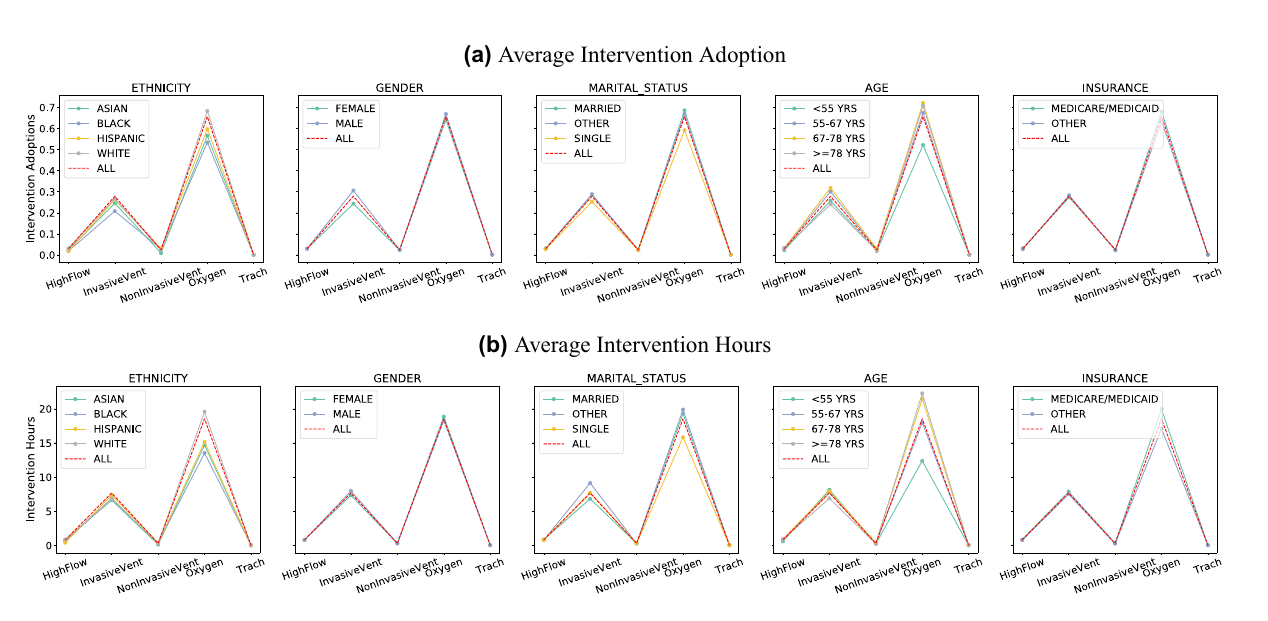
Figure 5. Average adoption and hours of intervention in general and in subjects from different